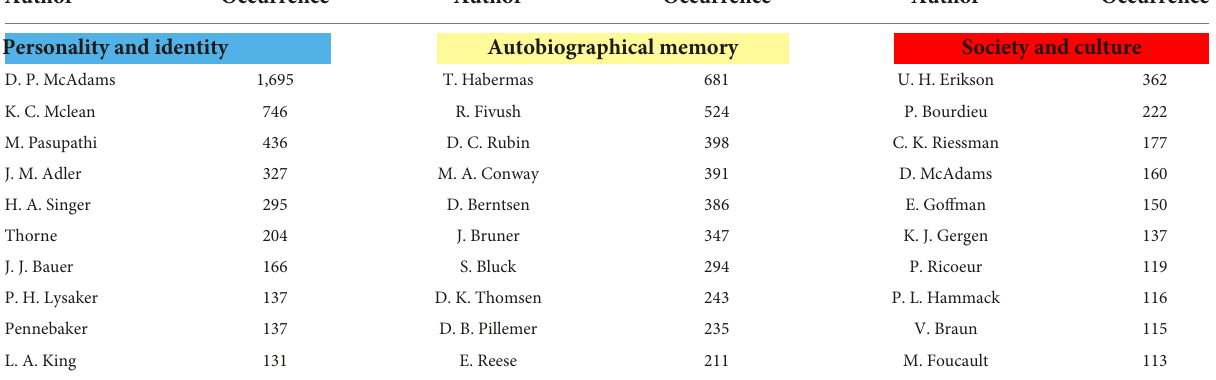
TABLE 4 Main producers of each school of